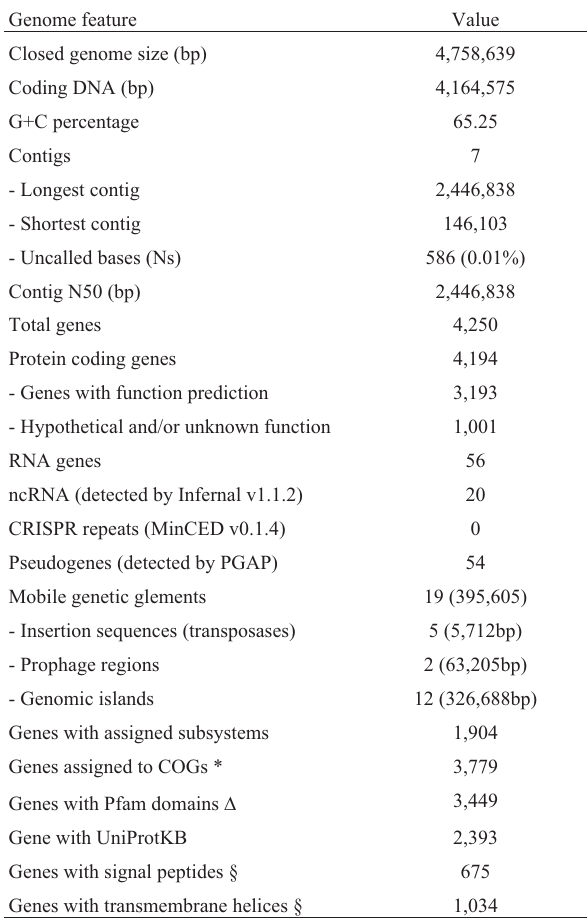
Table 1 - Genomic features of Dyella jiangningensis FCAV